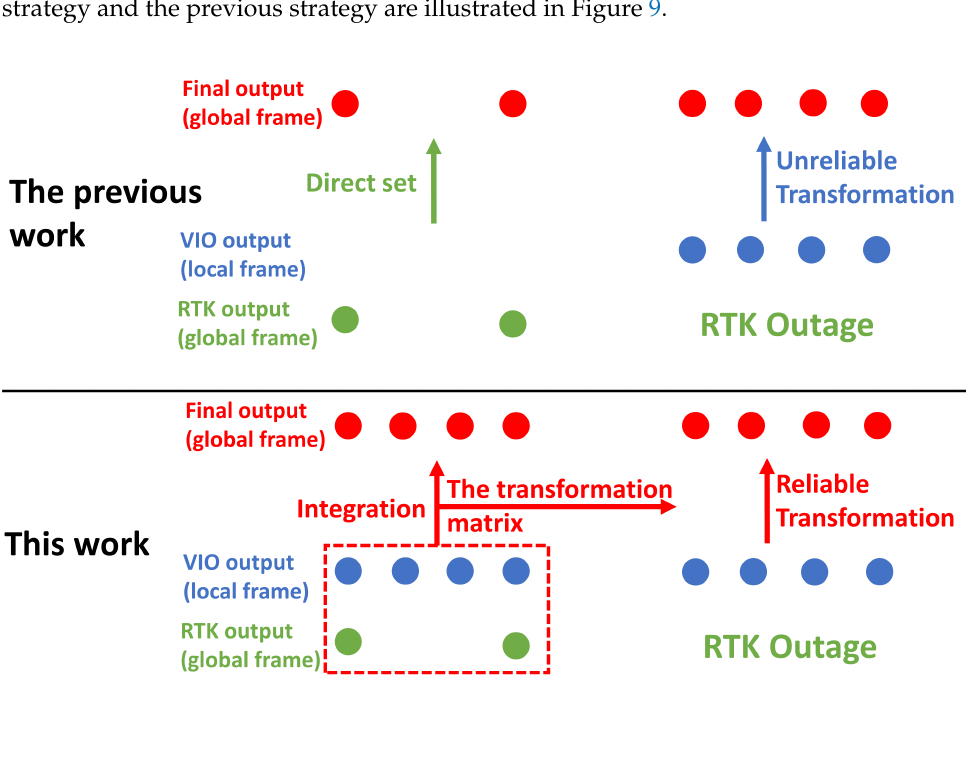
Figure 9. Differences between the current strategy and the previous